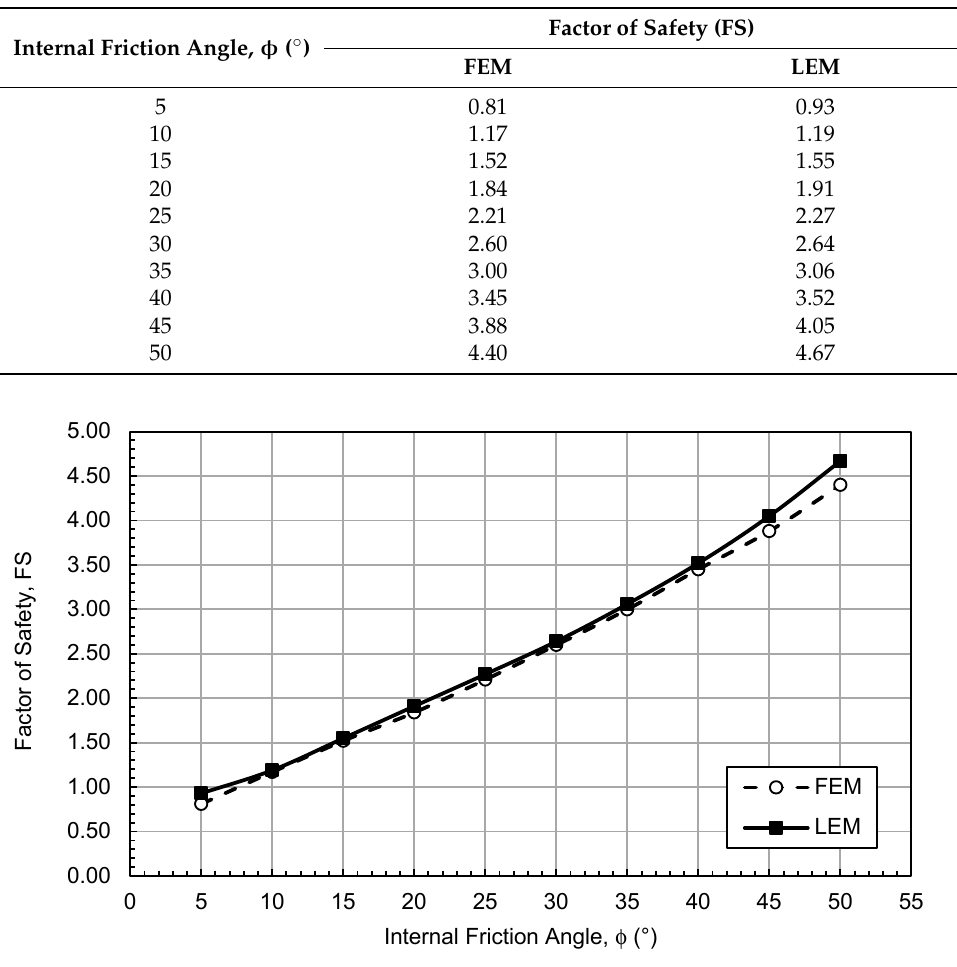
Figure 5. Variation in FS with ϕ .